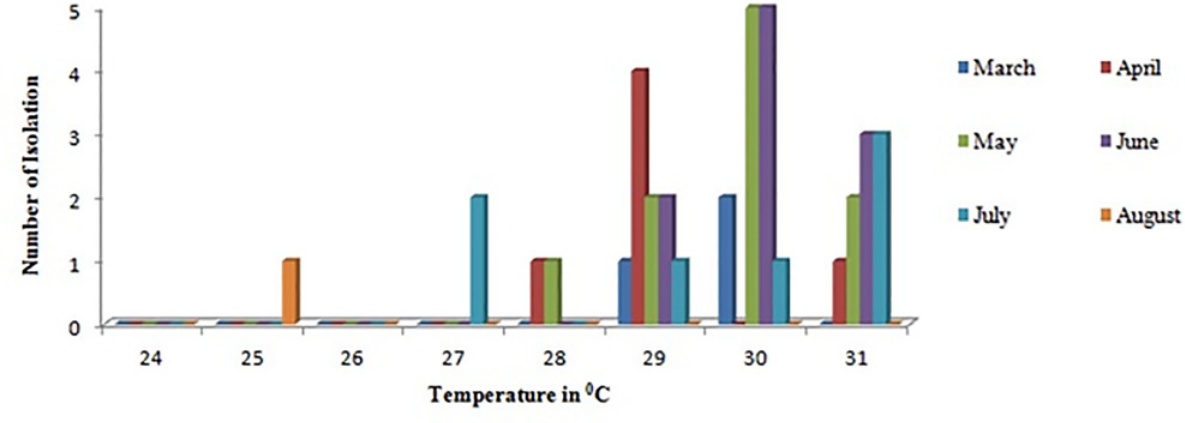
Fig 5. Graph depicting the association between temperature of the sampling sites and isolation frequency of Naegleria spp. Y axis denotes the number of isolation and X axis denotes minimum and maximum temperature range of the sampling sites during the entire season (March to